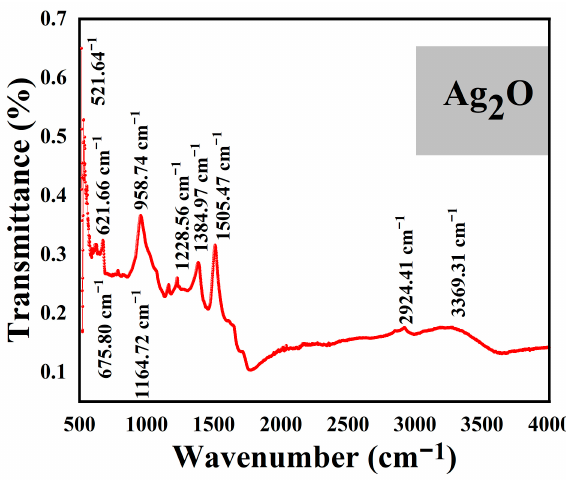
Figure 4. FT-IR spectra of P . alsinaefolia Ag 2 ONPs determining different functional groups. Table 2. Functional group that linked with the surface area of the P. alsinaefolia -Ag 2 ONPs.